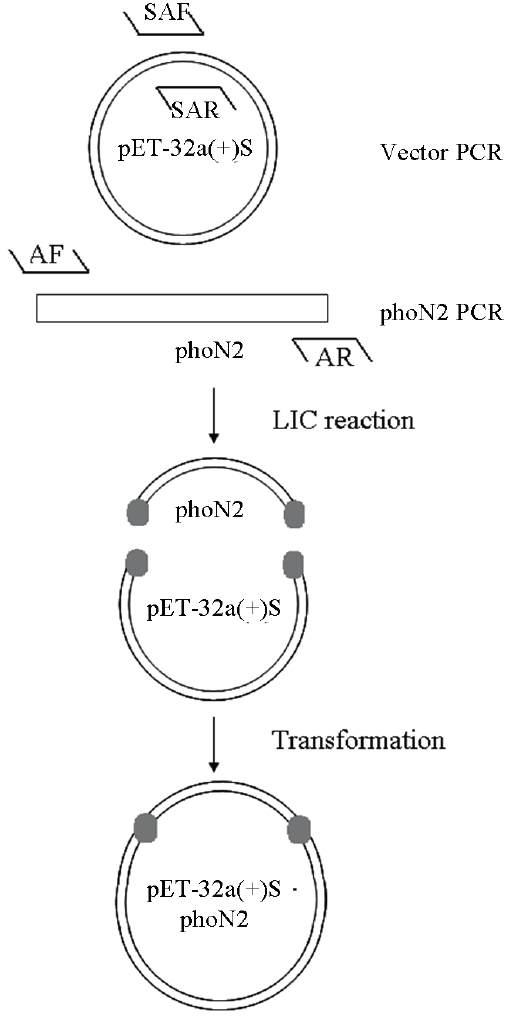
Figure 8. Construction of pET32a (+)